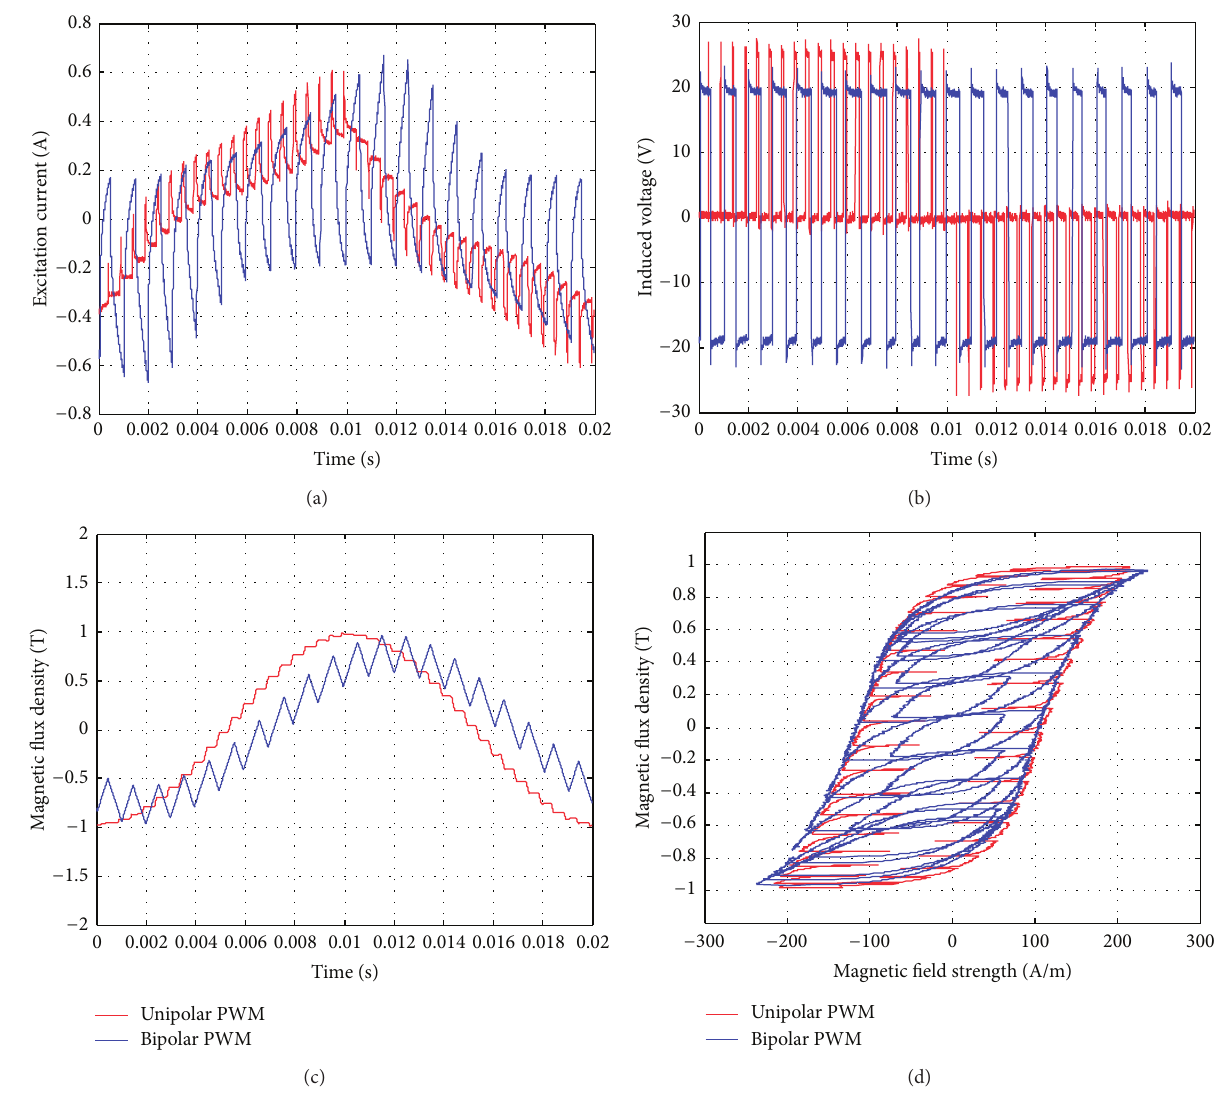
Figure21:ParametersmeasuredusingthenewtoroidalframeforbipolarandunipolarPWM(with 𝐵 =1T, 𝑓 =50Hz, 𝑚 𝑎 = 0.3 ,and 𝑚 𝑓 = 20 ): (a) excitation current, (b) induced voltage, (c) flux density, and (d) hysteresis